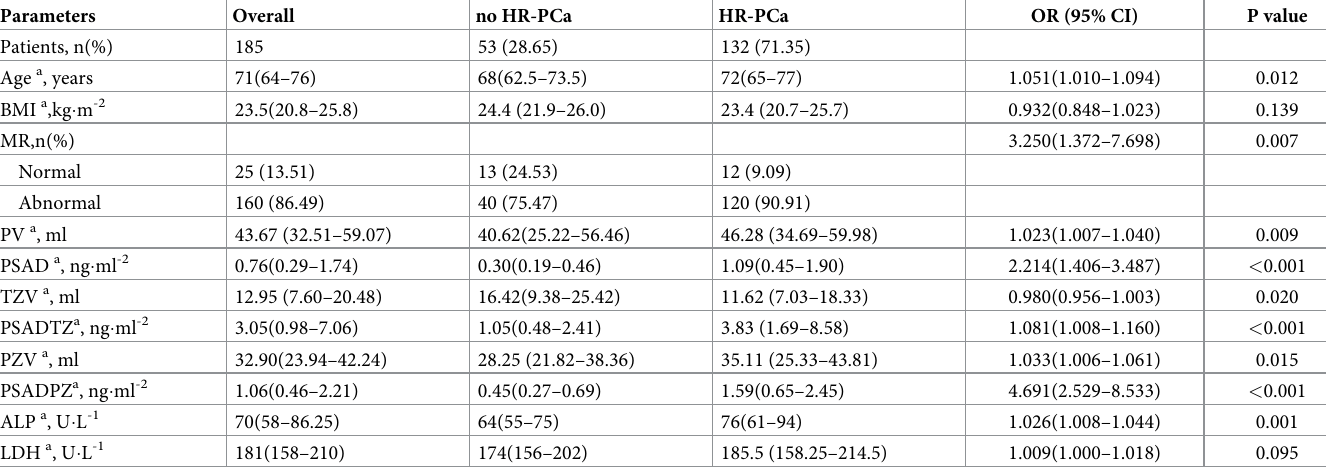
Table 2. Clinical characteristics of patients with no HR-PCa and HR-PCa at the initial